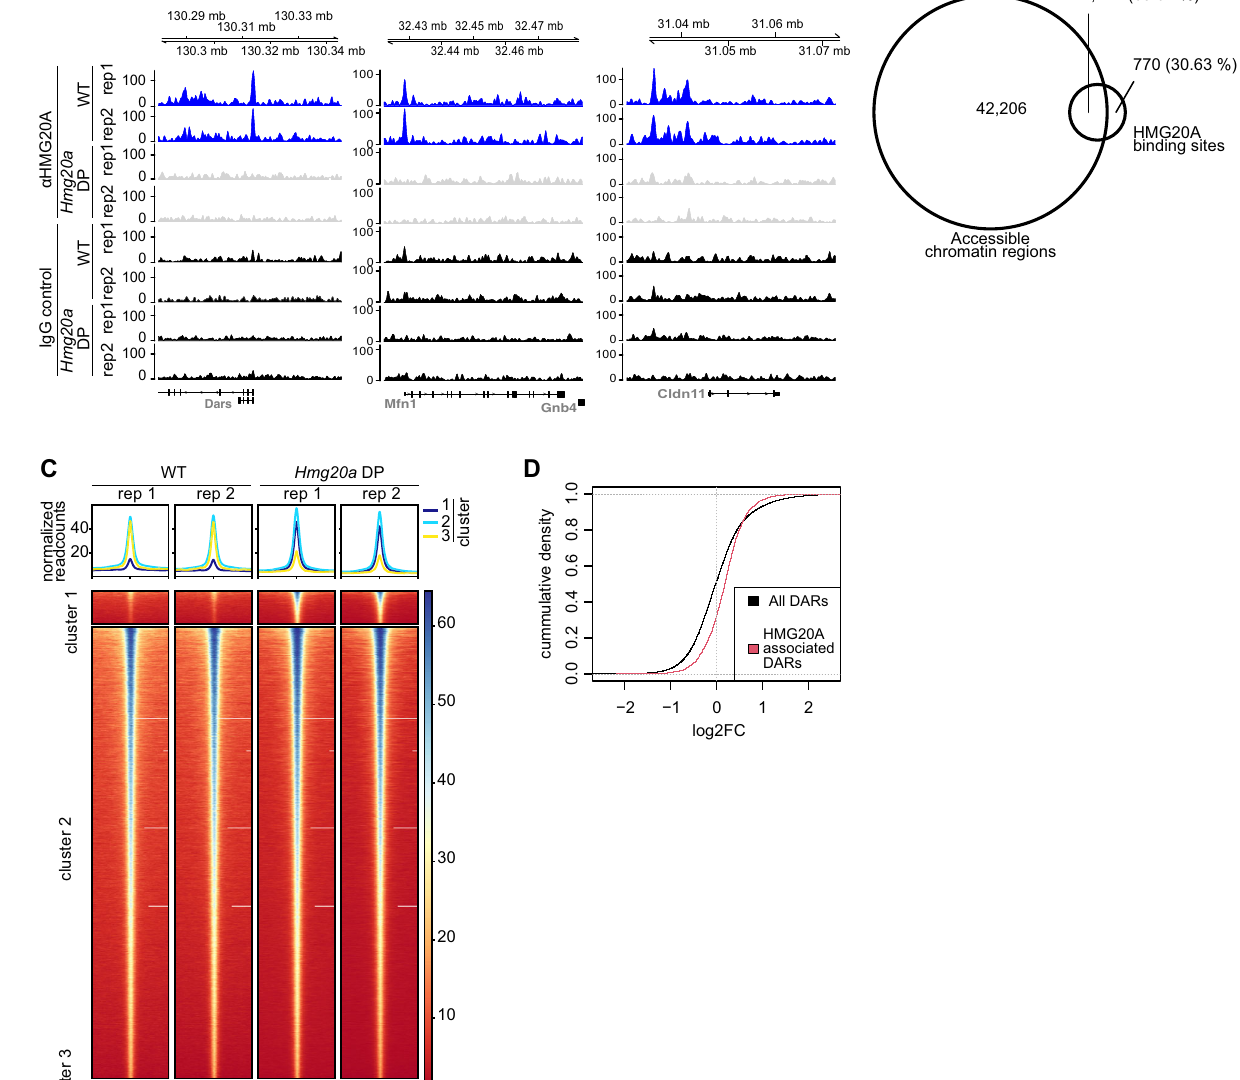
ATAC-seq identi fi ed accessible chromatin regions. C Density heatmap of ATAC-seq sites(tworeplicates)thatbecomemoreopen(cluster1),remainunaffected(cluster2) or become more closed (cluster 3) upon Hmg20a depletion. D Cumulative density plot showing the distribution of the observed changes in chromatin accessibility (shown as log2FC (DP/ET)) for all ATAC-seq signals (black) and for those ATAC-seq signals overlapping with HMG20A (red). DARs: differentially accessibly